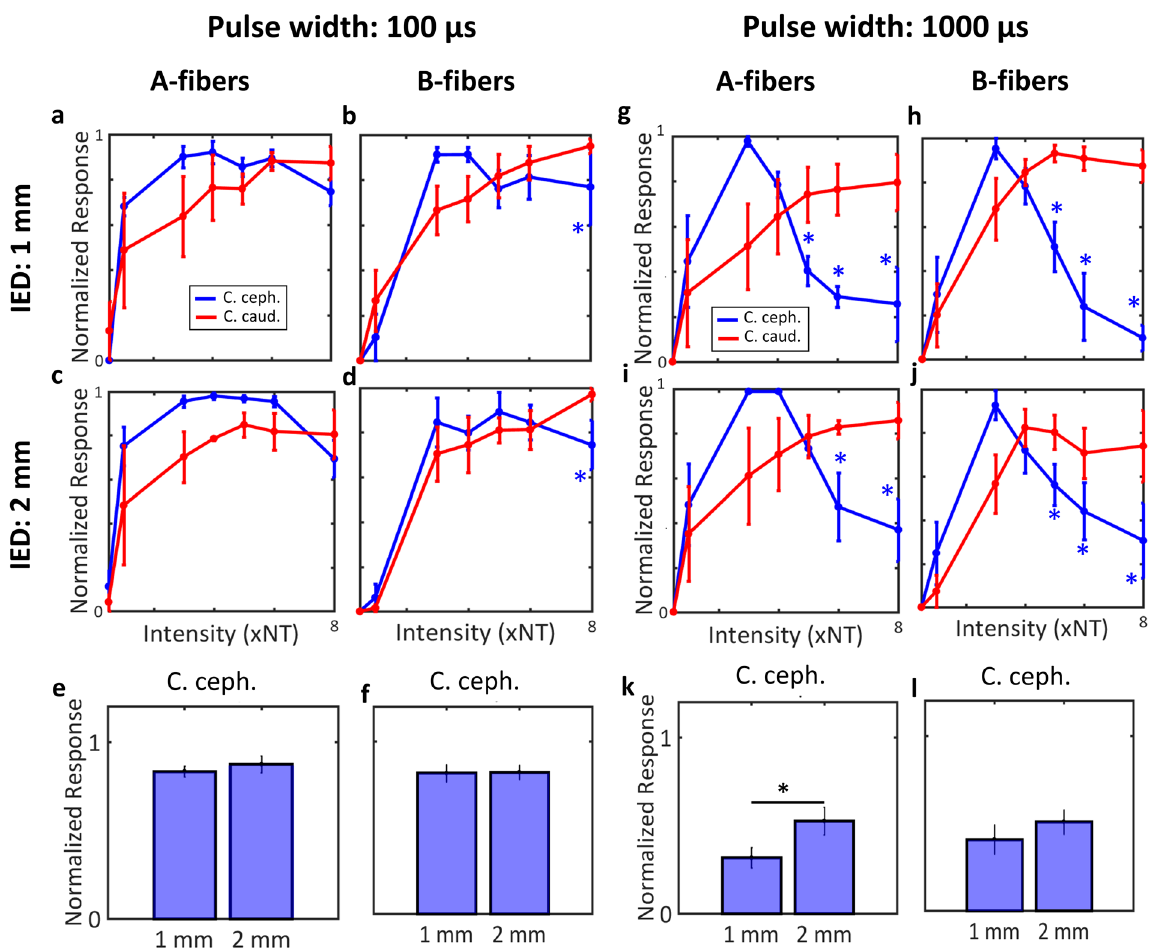
Figure 5. Stimulus polarity and average A- and B-fiber response magnitudes, for different pulse widths and inter-electrode distances. ( a,b ) Average (mean ± SEM, 4 animals) response magnitudes of A- and B-fibers, respectively, to stimuli with short pulse width (100 μ s), delivered through a bipolar electrode with 1 mm- inter-electrode distance (IED). Shown are the responses to both polarities, as a function of stimulus intensity. Blue asterisks denote statistically significant intensity levels at which anodal block of the corresponding fibers occurred (i.e. the response to cathode cephalad polarity became smaller that of the cathode caudad; paired t -test, p < 0.05). ( c,d ) Same as before (panels a,b), with an IED of 2 mm. ( e,f ) Comparison of average response magnitudes of A- and B-fibers, respectively, for cathode cephalad polarity, between 1 mm- and 2 mm-IED, for short pulse widht: 100 μ s (paired t -test, p NS). ( g,h ) Average response magnitudes of A- and B-fibers, respectively, to stimuli with long pulse width (1000 μ s), delivered with an IED of 1 mm (paired t -test; blue asterisks denote p < 0.05). ( i,j ) Same as before (panels g,h), but with an IED of 2 mm (paired t -test; blue asterisks denote p < 0.05). ( k,l ) Comparison between 1 mm- and 2 mm-IED similarly to panels e and f, but for long pulse width: 1000 μ s (paired t -test, fig. k p = 0.05; fig. l p